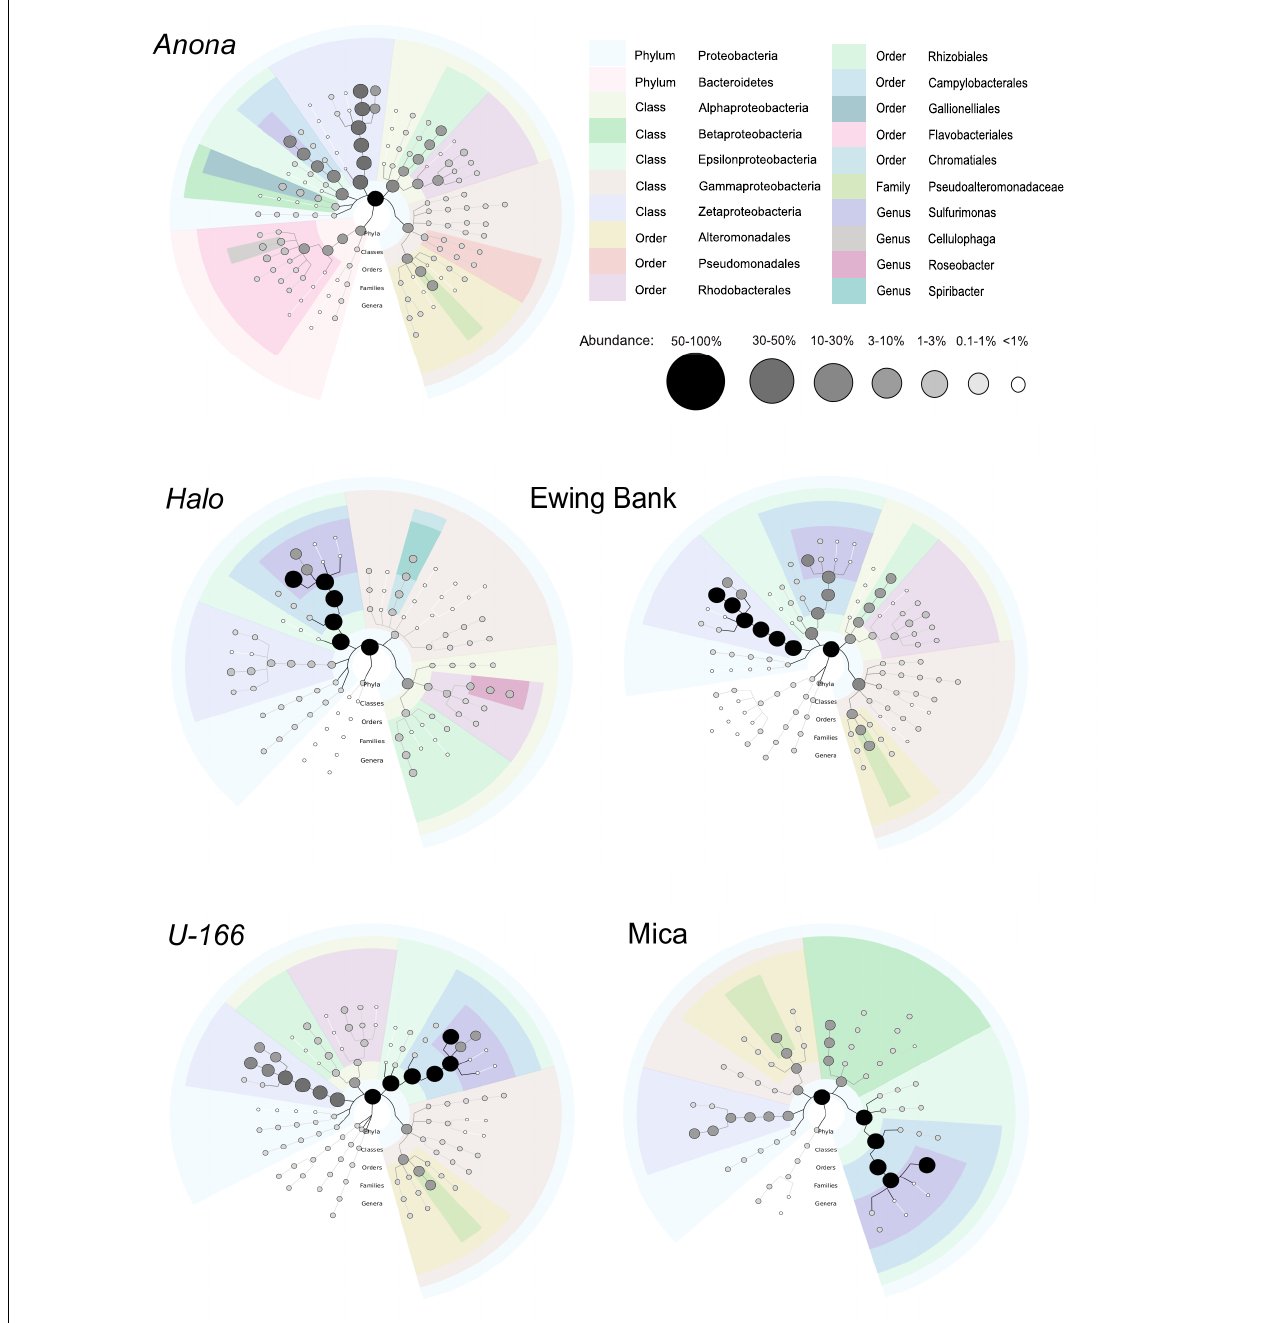
FIGURE 4 | Biofilm taxonomy from metagenome sequences of pooled replicate samples. Shaded bubbles represent percentage of abundance and colors represent taxonomic groups. Plots generated in